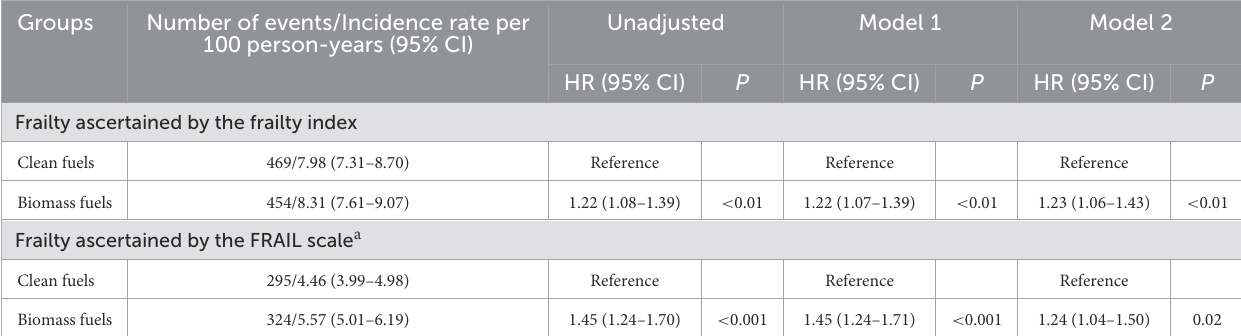
TABLE 2 The association between cooking fuels and frailty. Groups